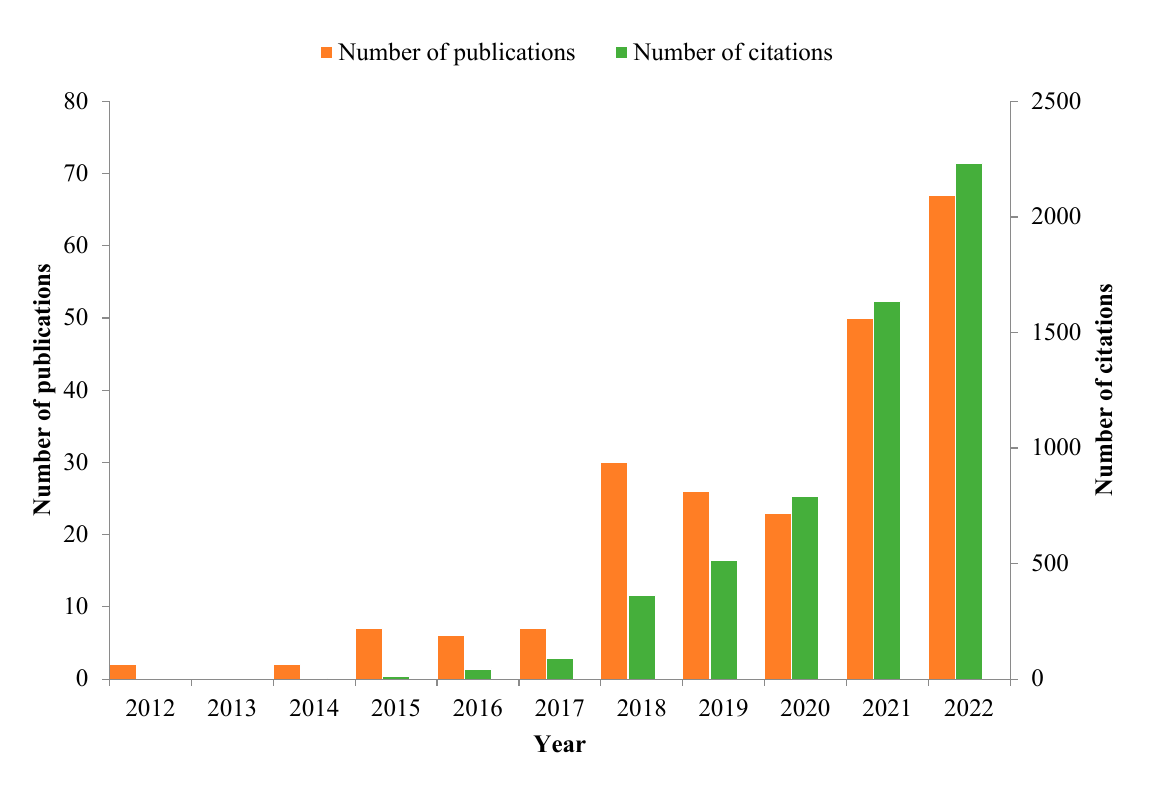
Figure 3. Number of publications and citations/year on 3D food printing over the last decade. The search was done on 1 November 2022, using the following search query criteria on the Scopus database: TITLE (3D food printing) OR (Additive food manufacturing).